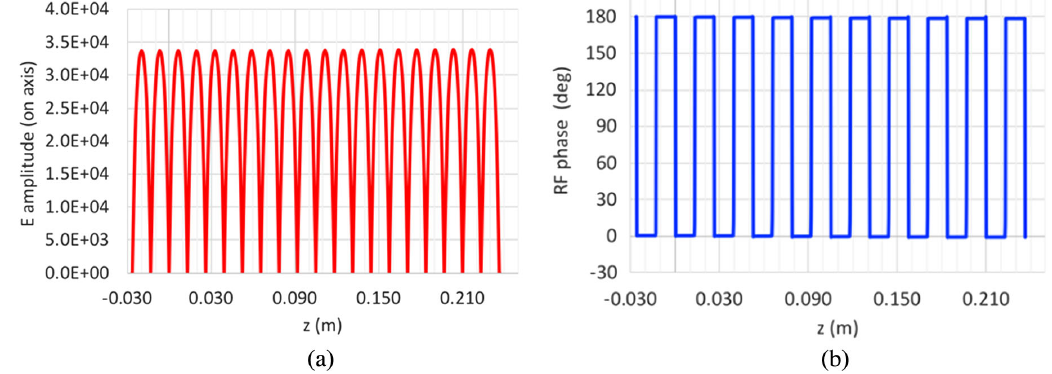
structure.FIG. 13. (a) The electric field amplitude on axis, with arbitrary units; (b) the π -mode phase in the 20-cell